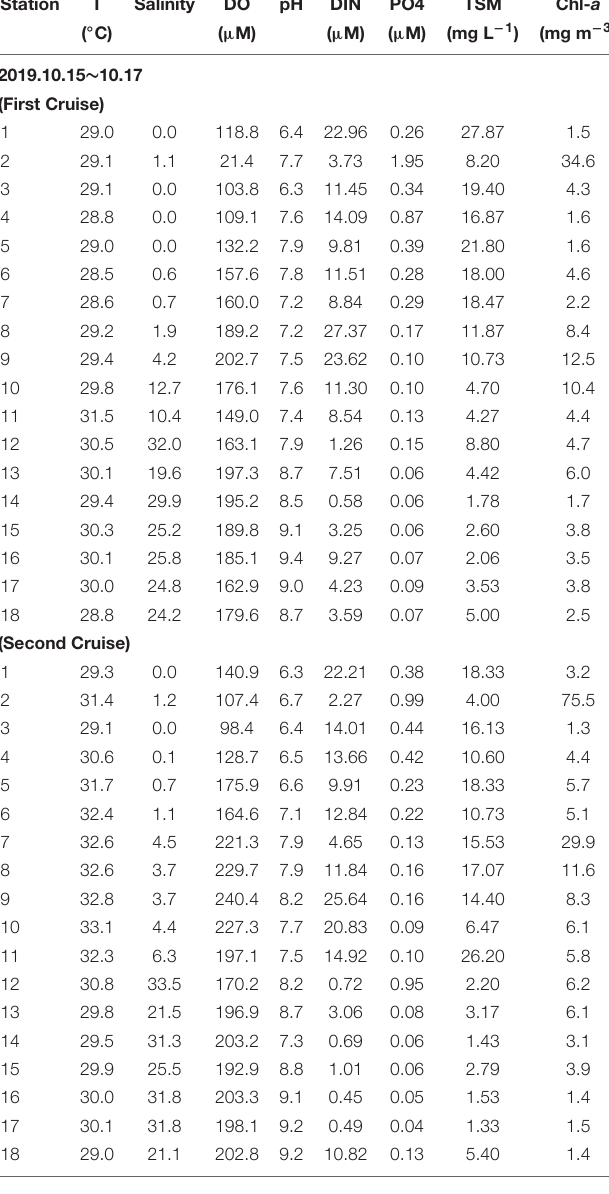
TABLE 3 | Water temperature, salinity, dissolved oxygen (DO), pH, dissolved nitrogen (NO3 + NO2), total suspended matter (TSM) and chlorophyll- a (Chl- a ) in the Negombo Lagoon in the wet season